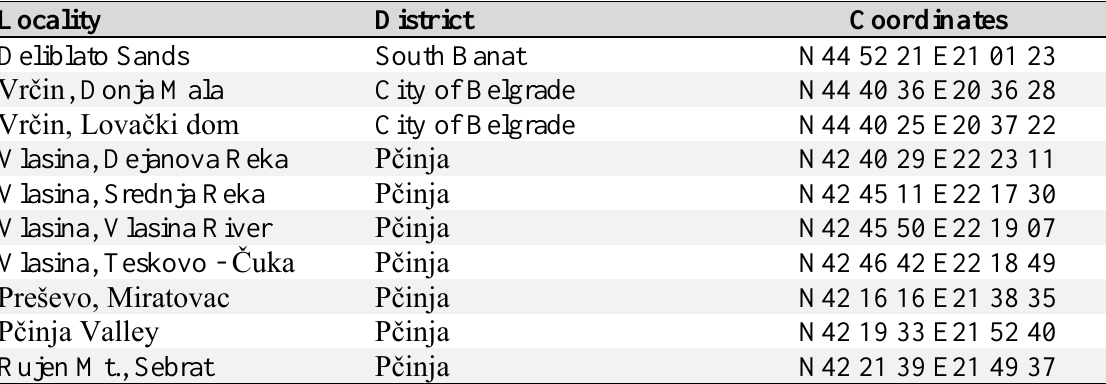
Table 1. Localities where new hoverfly species for the fauna of Serbia were found. Locality